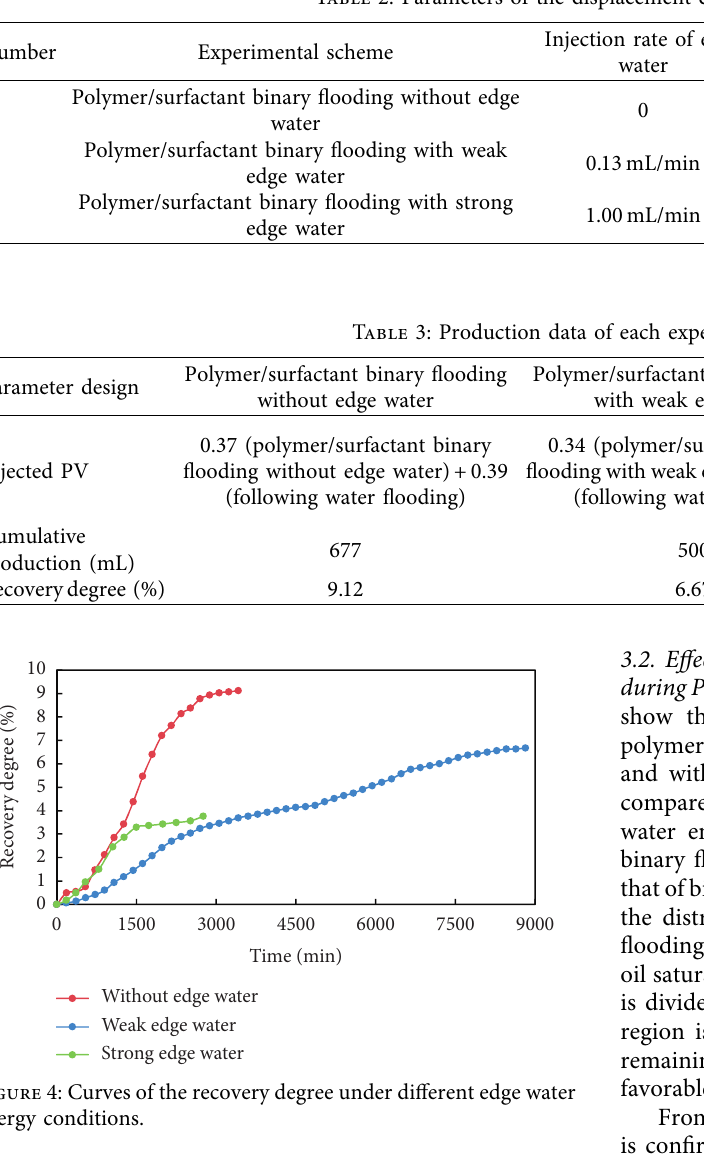
Table 2: Parameters of the displacement experiment scheme.